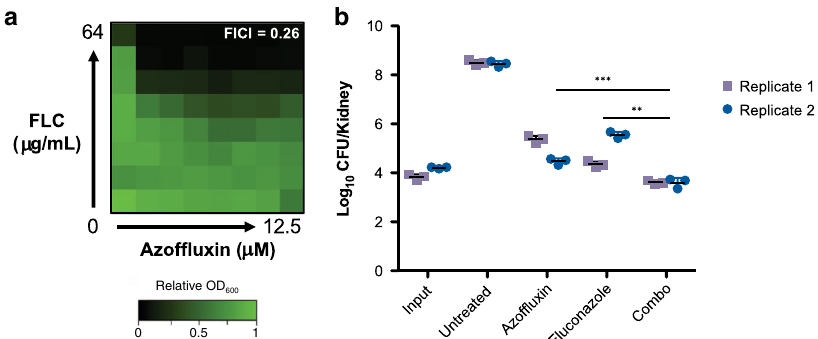
Fig. 8 Azof fl uxin increases the antifungal activity of fl uconazole (FLC) in mice. a Checkerboard assays were performed as described in Fig. 1b with C. auris clade IV isolate B11801. Relative growth was measured after 24 h using OD 600 and normalized to no-drug control wells (see color bar). The FICI is shown in the top right of each plot, with values <0.5 indicating synergy. b Kidney fungal burden (CFU) in mice from each treatment group that had been infected with C. auris B11801. Input is the CFU recovered in an aliquot of the fungal suspension used to inoculate mice. All other values are the CFU recovered from kidney homogenates after 4 days of treatment. Fluconazole was administered at 32 mg/kg intraperitoneally twice daily and azof fl uxin at 10 mg/kg subcutaneously four-times daily. Data are presented as mean ± SD of n = 3 mice per treatment group. Experiment was performed in two independent replicates (purple and blue). The signi fi cance of differences between combination treatment and treatment with each compound alone was determined for each replicate by two-sided unpaired Student ’ s t test, ** p -value < 0.01 and *** p -value < 0.001. Source data are provided as a Source Data fi